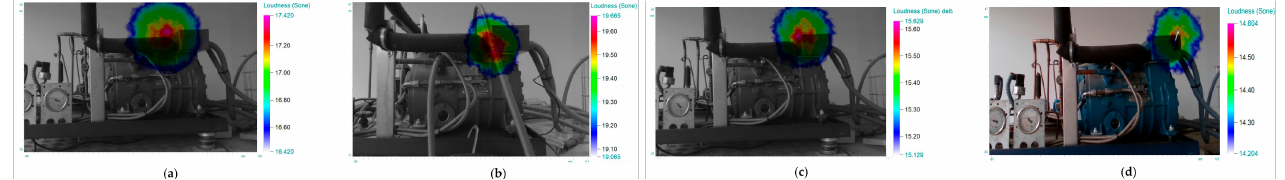
Figure 5. Identification of the sound source: ( a ) R-134A without control system, ( b ) R-449A without control system, ( c ) R-134A with control system, and ( d ) R-449A with control system.